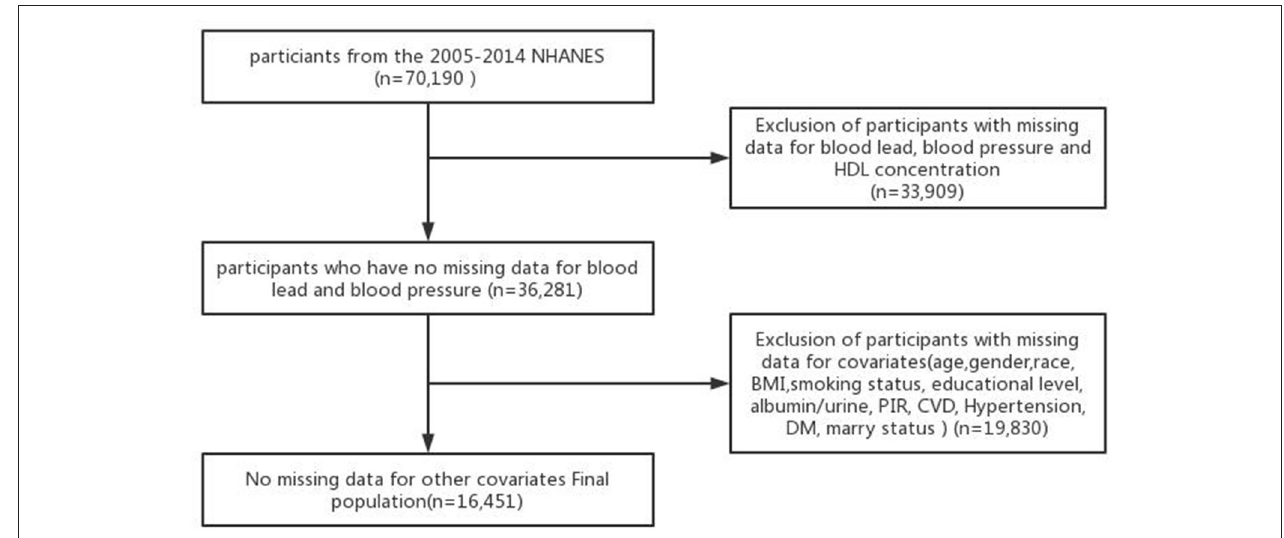
FIGURE 1 | Flowchart for exclusion